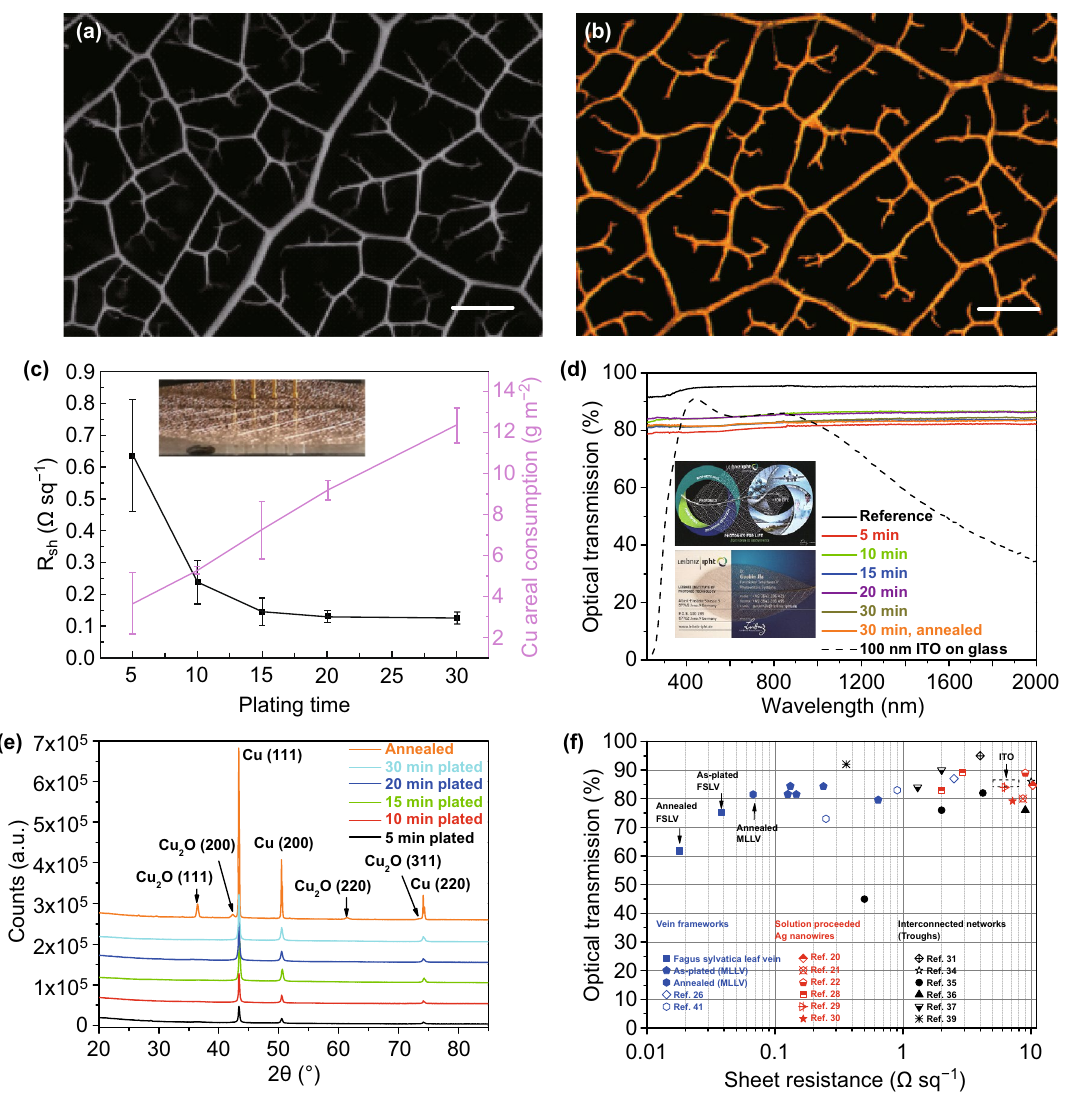
Fig. 2 a A micrograph of Magnolia liliiflora leaf vein (MLLV). b A micrograph of the 30 min electroless Cu‑plated MLLV; scale bars for both a and b: 500 µm. c The R sh (black) and Cu consumption on the veins (magenta) versus plating time. d Optical transmission of the pure and as‑ plated veins with different plating times and after annealing. A transmission spectrum of 100 nm ITO deposited on 0.7‑mm Borofloat glass for comparison. e XRD measurements of the as‑plated and annealed Cu layers. f A summary of the recently developed TCEs based on perforated networks with a R sh of below 10 Ω □ −1 and an optical transmission (at 550 nm) of around